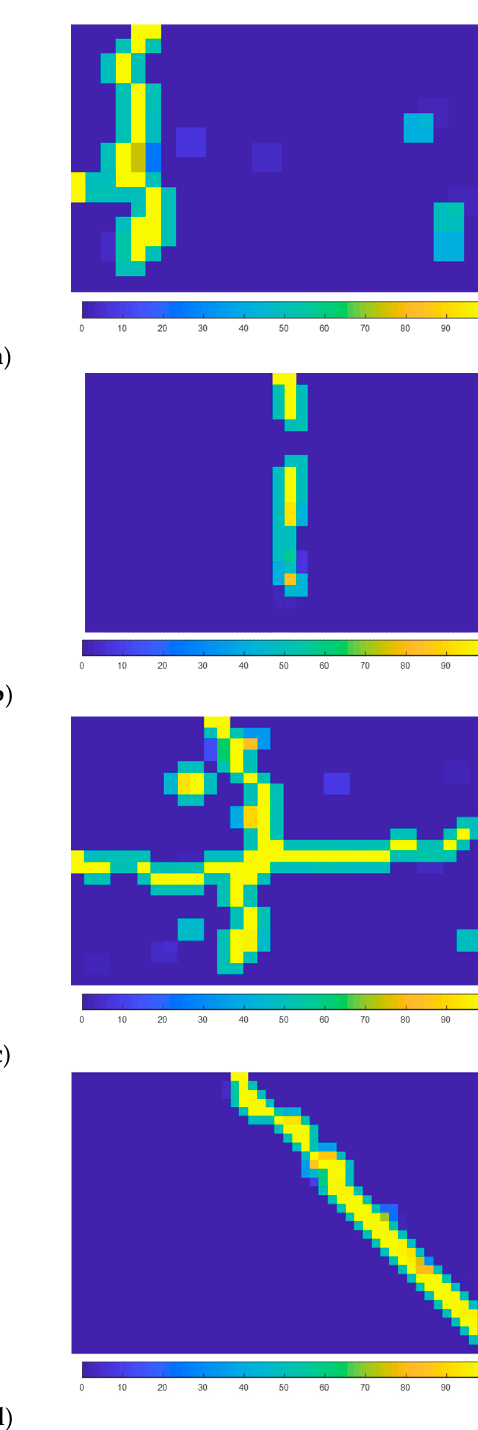
Table 2. The performance of the trained network was also tested on other 34 images of concrete surfaces which have similar patterns or textures and the results are tabulated in the Appendix A. The average accuracy is 97.02%, the average precision is 92.36% and the average recall is 89.28% for the result in